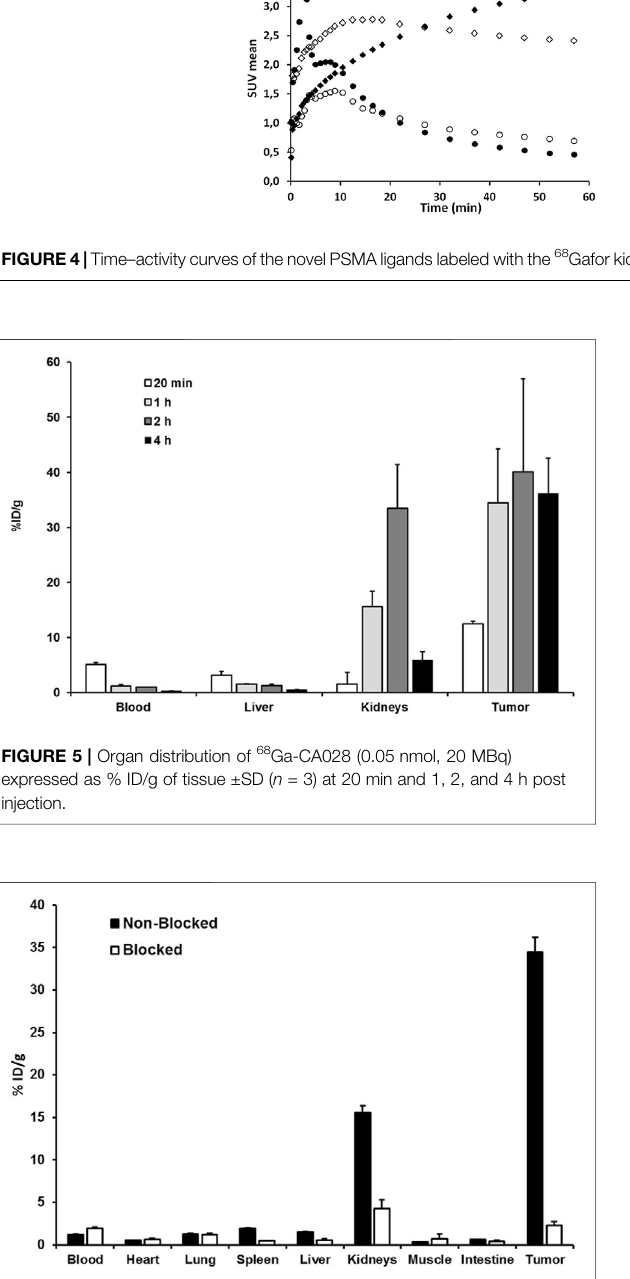
and 68 Ga-CA030 ( Supplementary Figure S4 ) are in line with the PET imaging. The graphics ( Figure 5 , Supplementary Figure S5 ) show the organ distribution at the time points of 20 min and 1, 2,